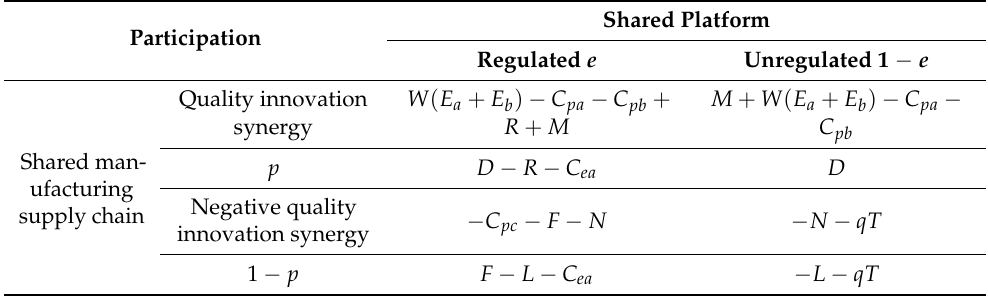
Table 1. Gain perception matrix.